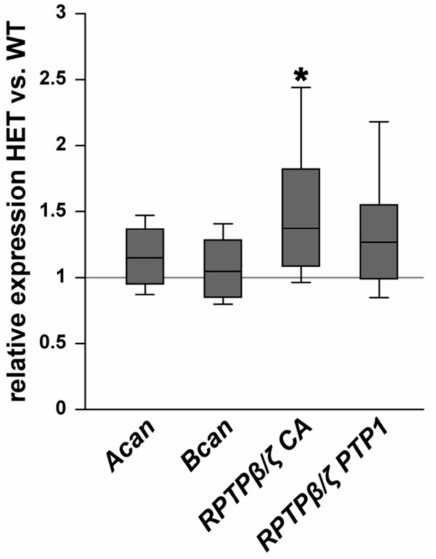
Figure 6. Upregulation of phosphacan expression in the glaucomatous HET retina. Analyses of Acan , Bcan, and RPTP β / ζ /phosphacan mRNA expression in the retina of WT and HET mice by RT-qPCR. We observed a significant upregulation of RPTP β / ζ /phosphacan detected by the primer pairs RPTP β / ζ CA (all isoforms). However, no changes in the expression of the RPTP β / ζ receptor variants, namely RPTP β / ζ long and RPTP β / ζ short , detected by the primer RPTP β / ζ PTP1 (receptor isoforms RPTP β / ζ long and RPTP β / ζ short ) were found. Collectively, these findings indicate that phosphacan is upregulated in the HET retina. A comparable mRNA expression level was detected for Acan and Bcan . Groups were compared using a pairwise fixed reallocation and randomization test. Data are shown as median ± quartile ± minimum/maximum. * p < 0.05. n =